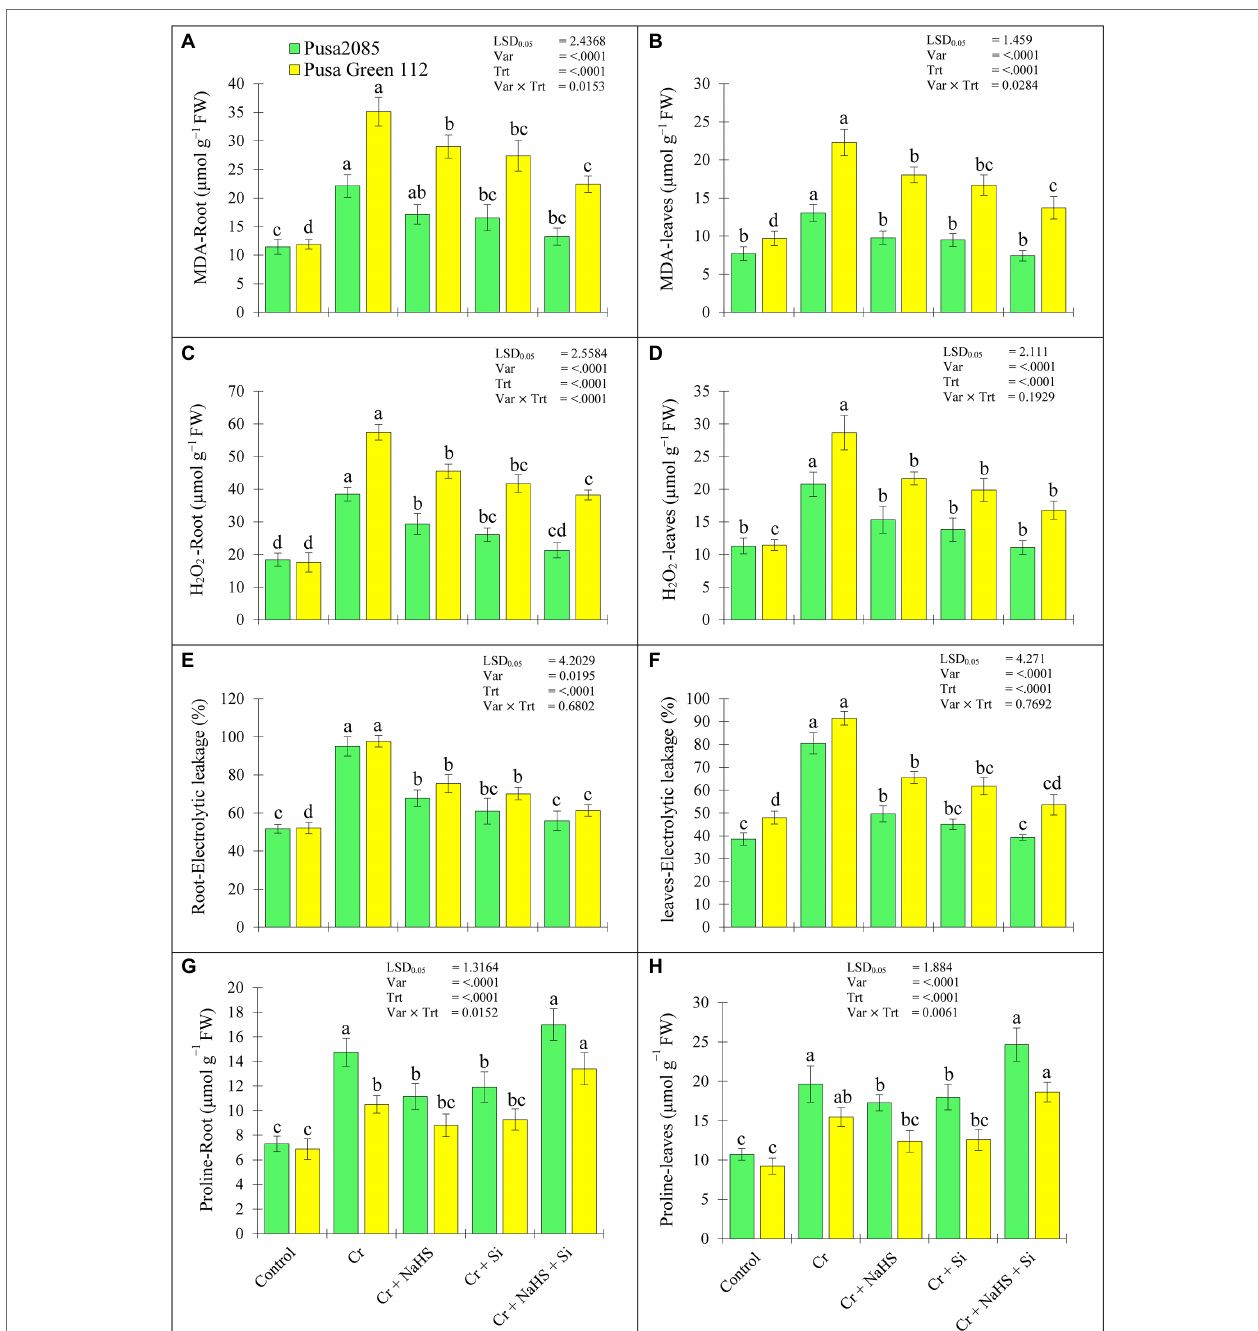
FIGURE 3 | Effect of NaHS, Si, and NaHS + Si treatments on (A, B) MDA—malondialdehyde, (C, D) H 2 O 2 —hydrogen peroxide, (E, F) EL%—electrolyte leakage, and (G, H) proline amount in roots and leaves of both chickpea plants grown during Cr VI stress. Data are presented as mean ± SE ( n = 5) and different bar letters are indicated statistically differences ( p < 0.05) as tested by the least significant difference